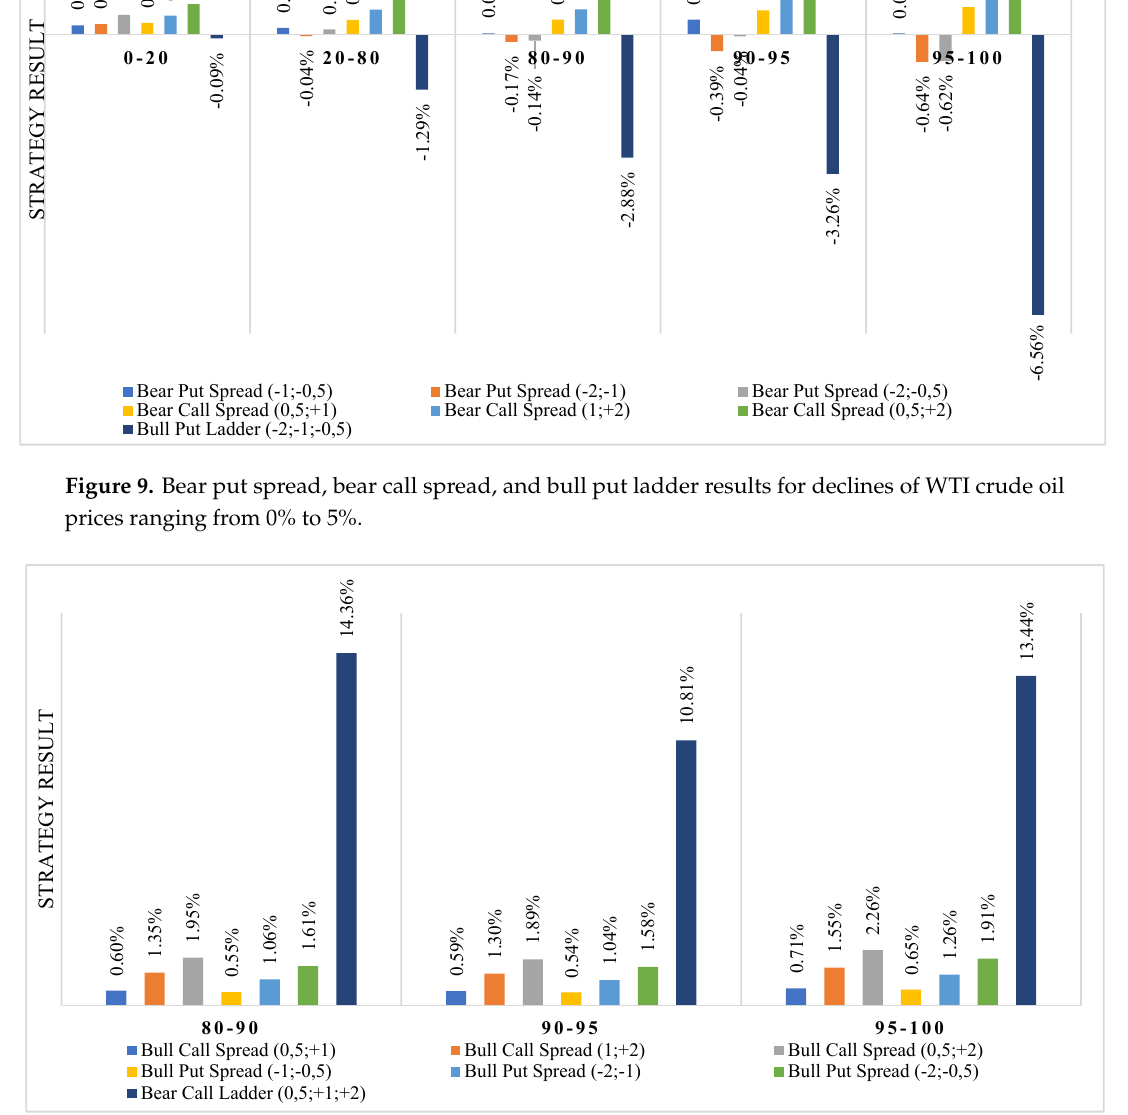
Figure 10. Bull Put Spread, Bull Call Spread and Bear Call Ladder results for increases of WTI Crude Oil prices exceeding 20%.